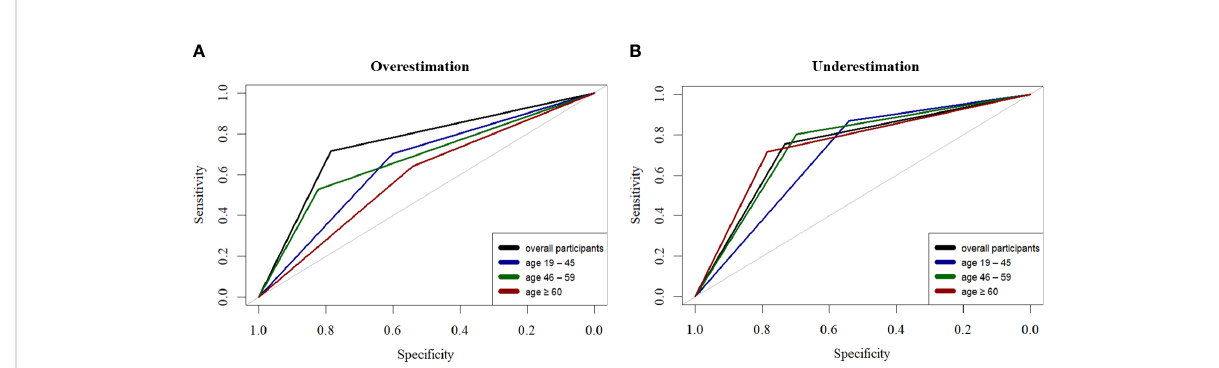
FIGURE 4 Performance of the decision tree-based ensemble model for predicting self-perceived body weight status in the overall dataset (n = 22,121); participants in the age groups of 19 – 45 years (n = 9,006), 46 – 59 years (n = 5,909), and ≥ 60 years (n = 7,206). (A) Receiver operating characteristic (ROC) curves of predicting overestimating pattern, and (B) underestimating pattern in different age